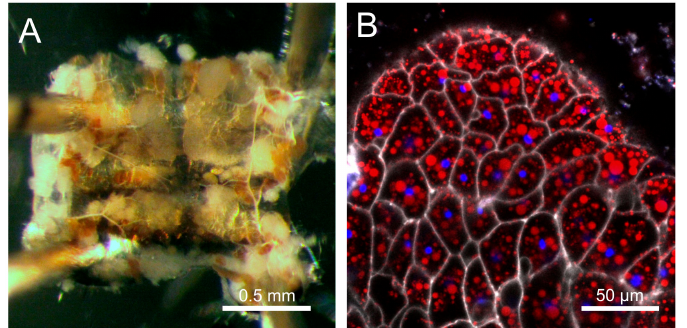
Figure 2. The fat body of Drosophila . ( A ) Bright-field image of a subcuticular fat body (white tissue) attached to the abdominal cuticle. ( B ) Confocal microscope image of the fat body. Cell membranes in white (CellMask Deep Red), lipid droplets in red (BODIPY 493/503) and DNA in blue (Hoechst